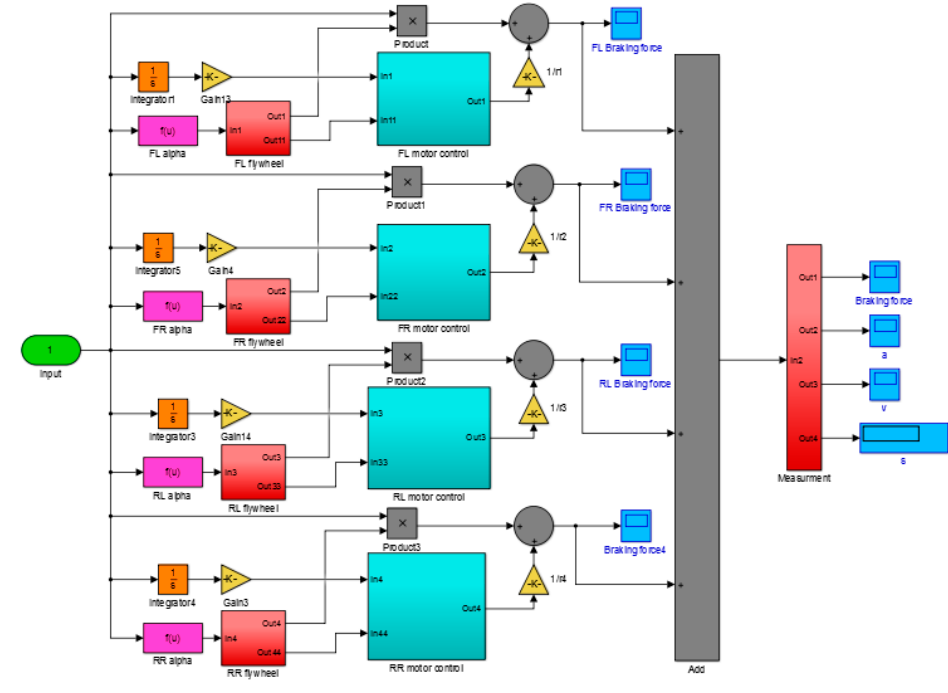
Figure 6. Vehicle test bench system simulation model.